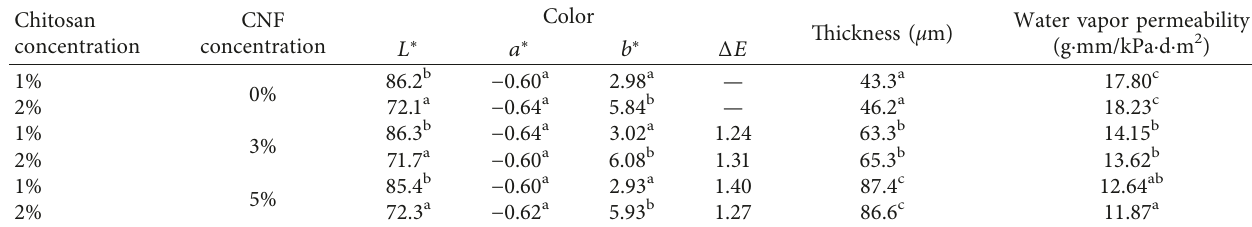
Table 1: Color, thickness, and water vapor permeability for different film formulations.